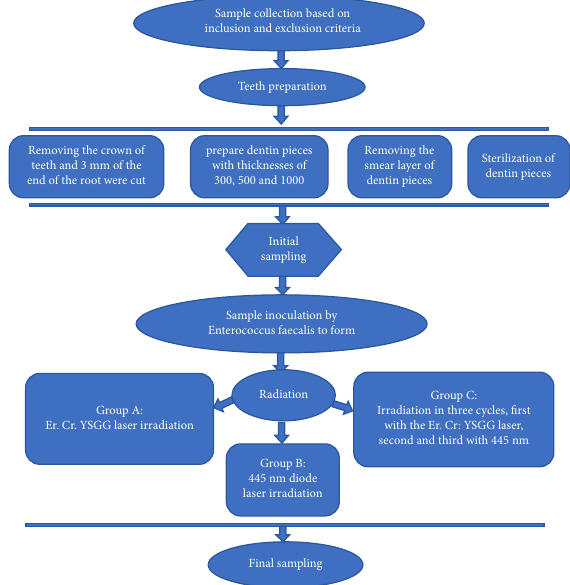
Figure 1: Flowchart for design